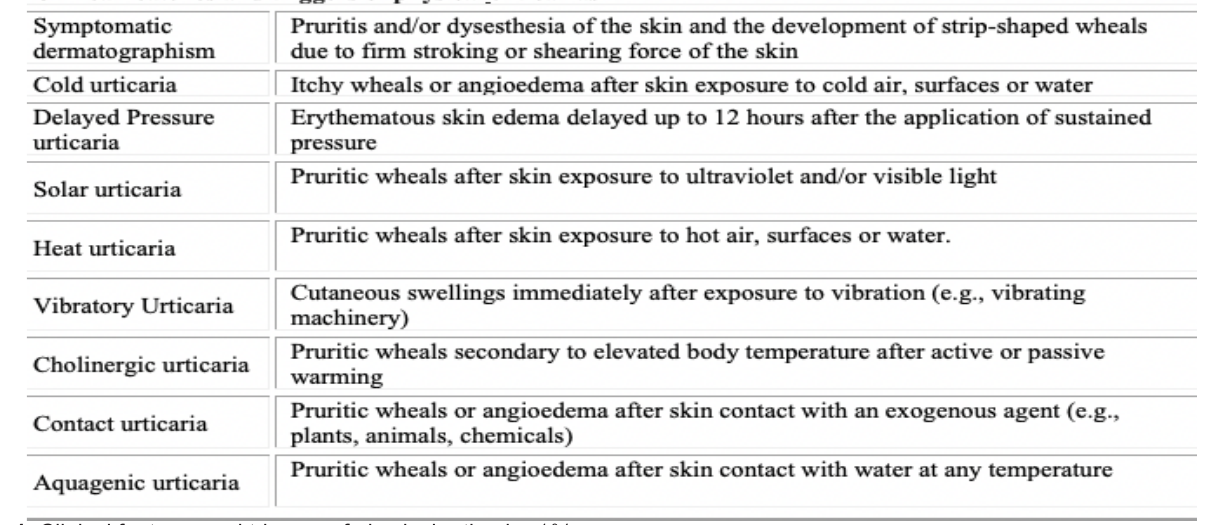
Figure 1. Clinical features and triggers of physical urticarias.